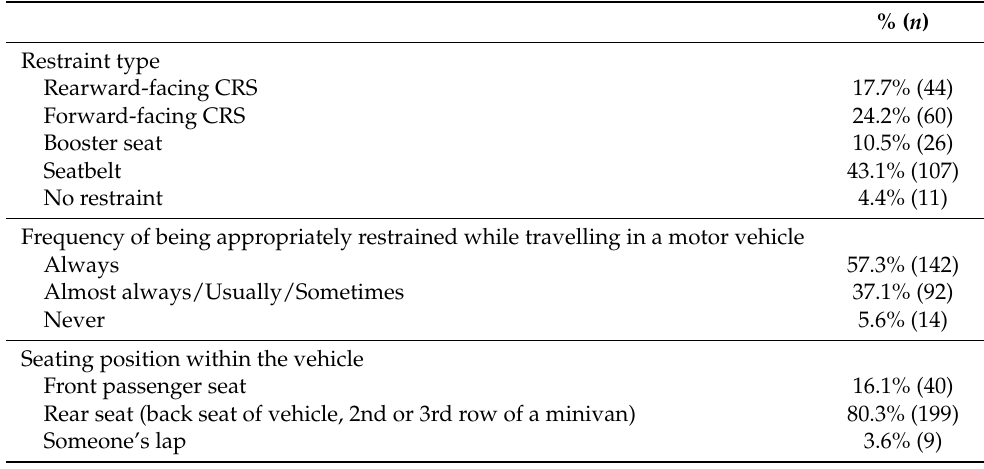
Table 7. Participants’ youngest child’s restraint in a rideshare vehicle over the past two years ( n =